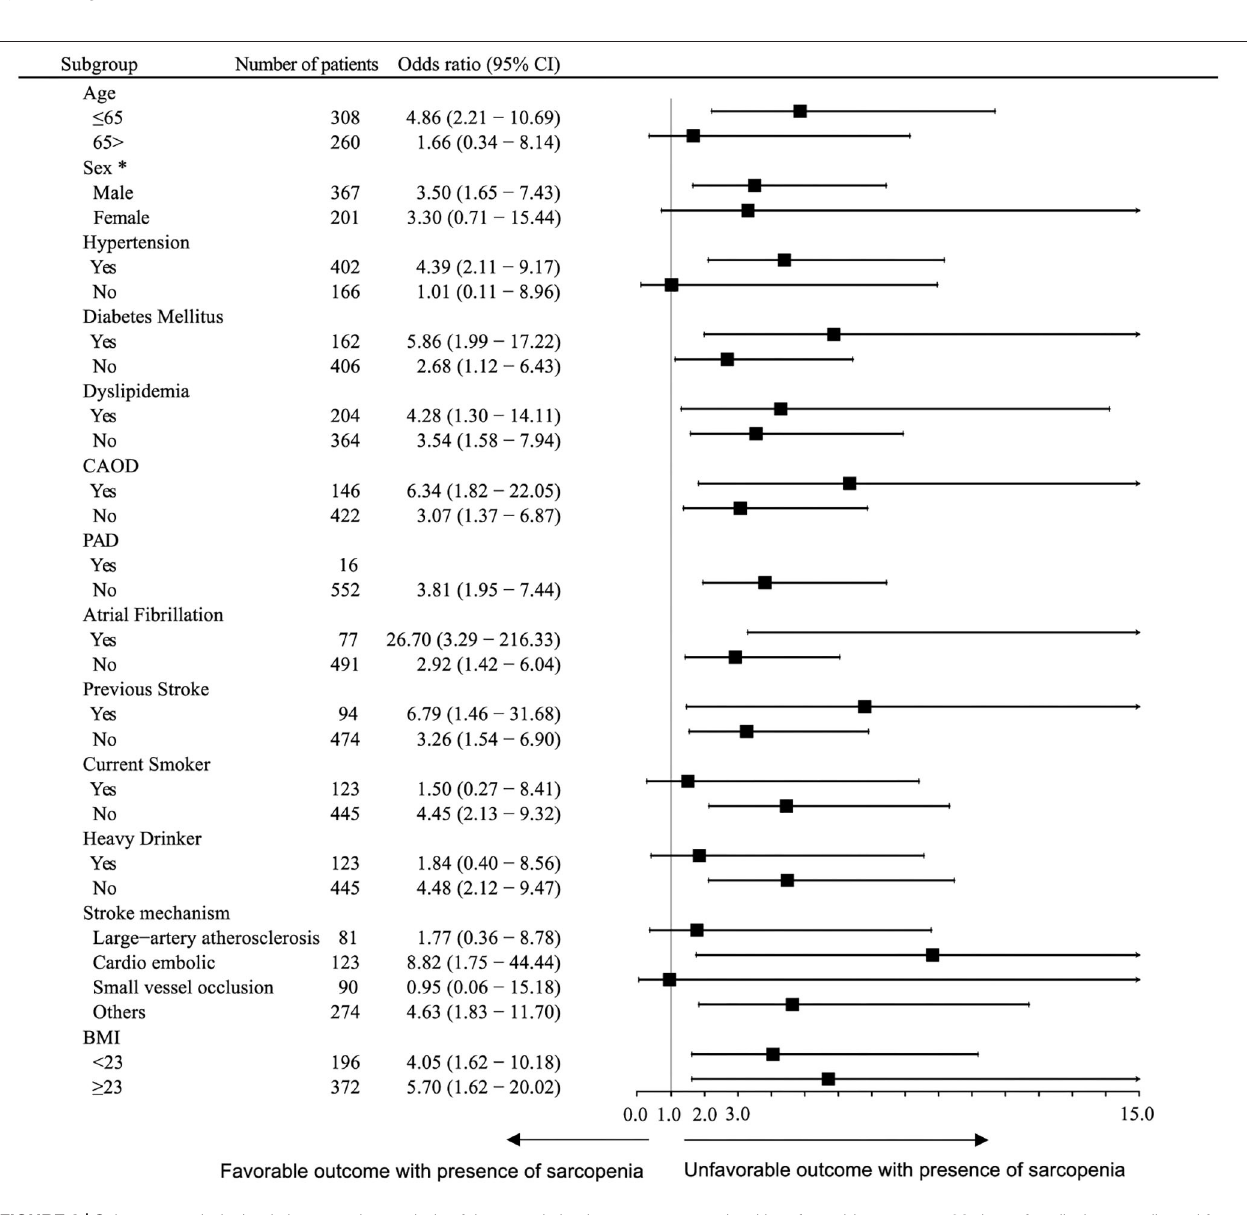
FIGURE 2 | Subgroup analysis. Logistic regression analysis of the association between sarcopenia with unfavorable outcomes 90 days after discharge, adjusted for sex and age. *Adjusted for age only. CI, confidence interval; NIHSS, national institute of health stroke scale. We also demonstrated the association between sarcopenia and stroke outcome were more evident in men than in